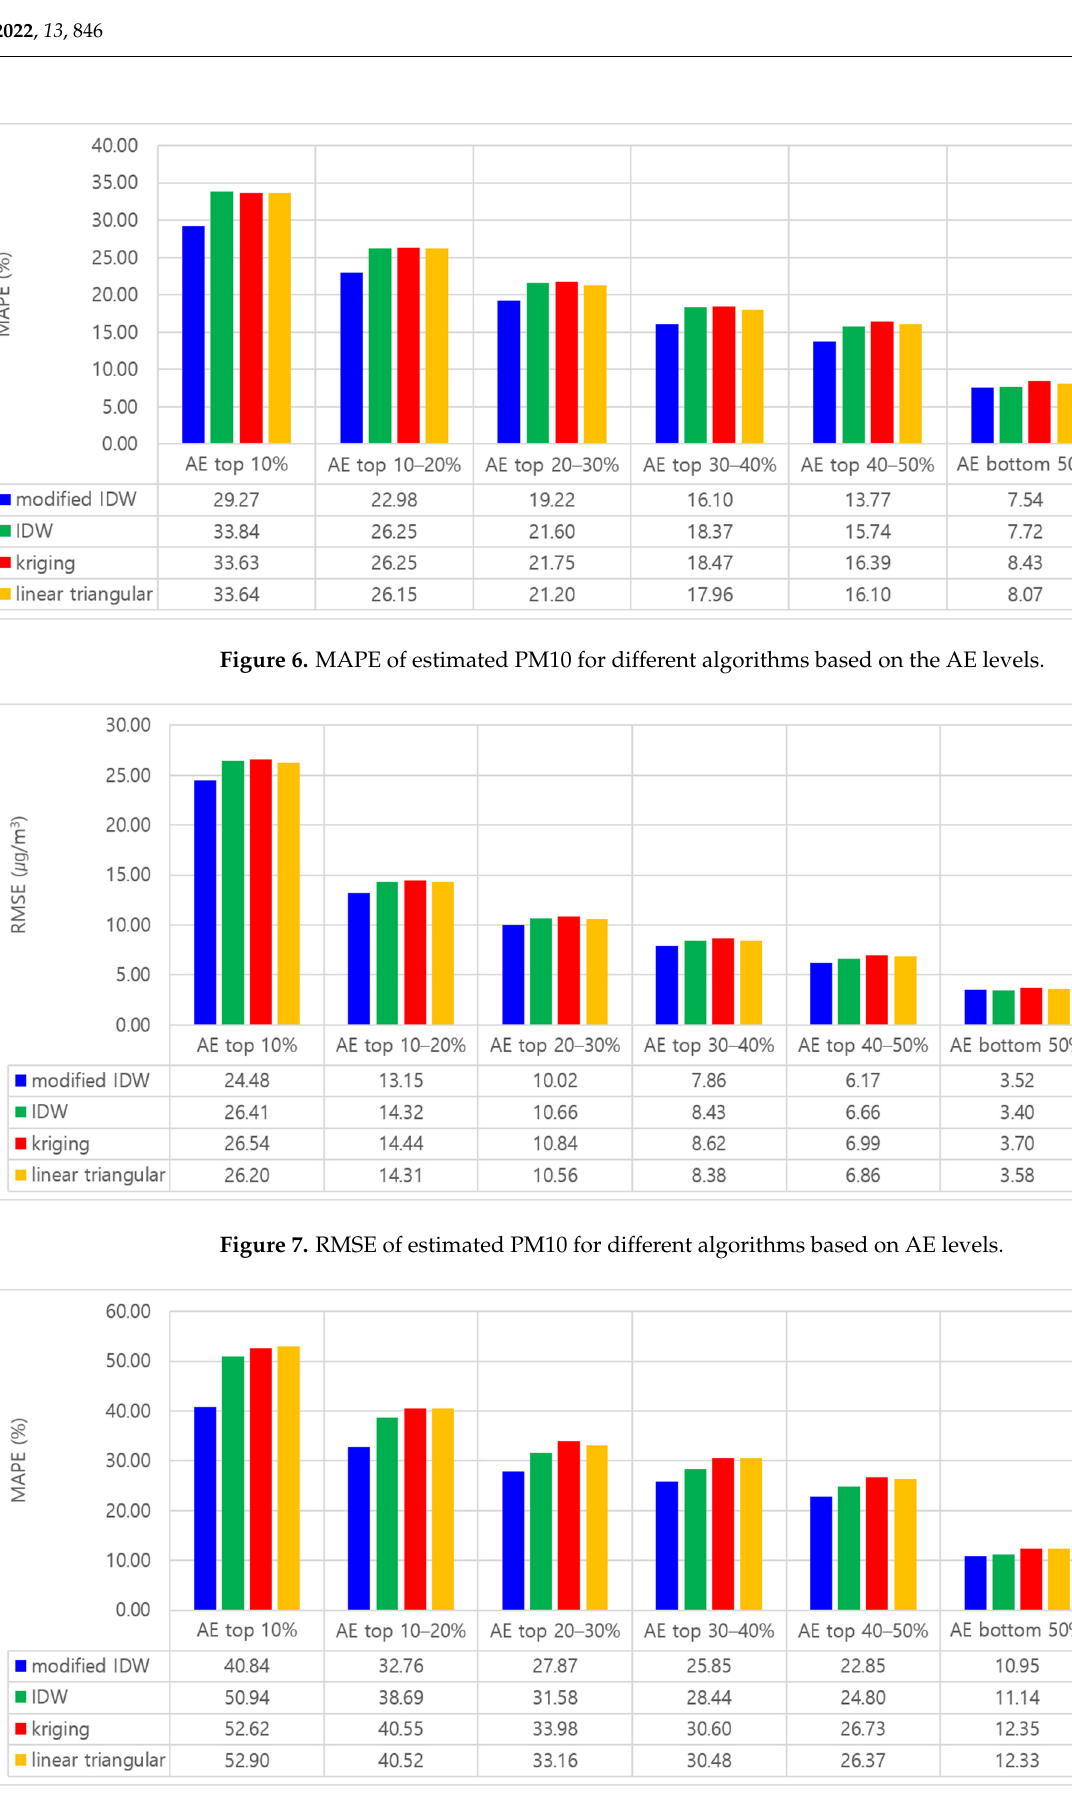
Figure 9. RMSE levels of estimated PM2.5 for different algorithms based on AE levels. In this study, the error is confirmed for each validation station to evaluate the pro- posed method precisely (Table 3). Among all the validation stations, those that exhibited the highest error based on RMSE were the stations 131192 (20.98 μ g/m³) and 131232 (15.10 μ g/m³). The reason that estimations of stations 131192 and 131232 show relatively lower accuracy is as follows. Most spatial interpolation methods, including the proposed method, determine the estimate within the maximum and minimum range of observa- tions. Therefore, without observations for a point showing a significantly different PM concentration, the accuracy of PM estimations can be decreased, where stations 131192 and 131232 are located near the industrial areas (Sihwa and Banwol industrial complex), and the reference stations around them are located in residential areas (Figure 10), and they show consistently higher concentrations of PM10 and PM2.5, respectively. At the time of observation (the year 2020), monthly mean PM10 concentrations of station 131192 were 19–25 μ g/m³ higher, and monthly mean PM2.5 concentrations of station 131232 were up to 12 μ g/m³ higher than the surrounding reference stations. On the other hand, the PM2.5 concentration of station 131192 and the PM10 concentration of station 131232 did not show a significant difference from those of neighboring reference stations. This ten- dency of PM distribution explains the reason for the highest errors in the two stations.